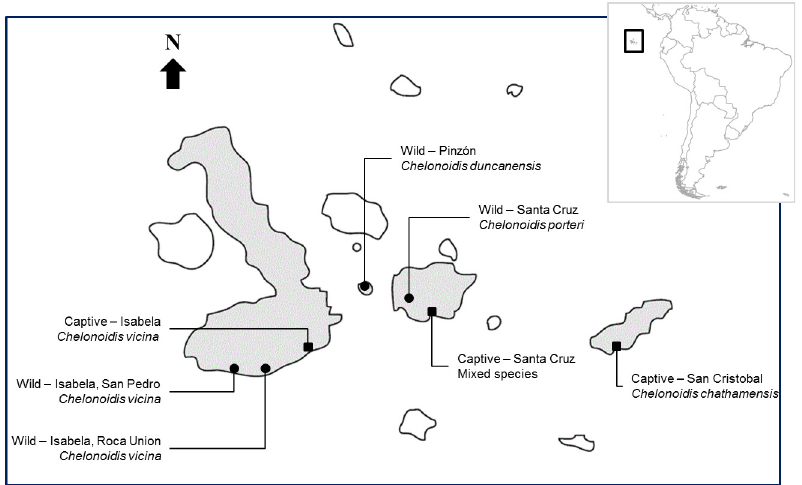
Fig 1. Map showing the locations where faecal samples were collected on the Galápagos Islands. Squares depict captive populations, circles depict wild populations. Inset — map of South America highlighting (in square) the location of the Galápagos Islands relative to the